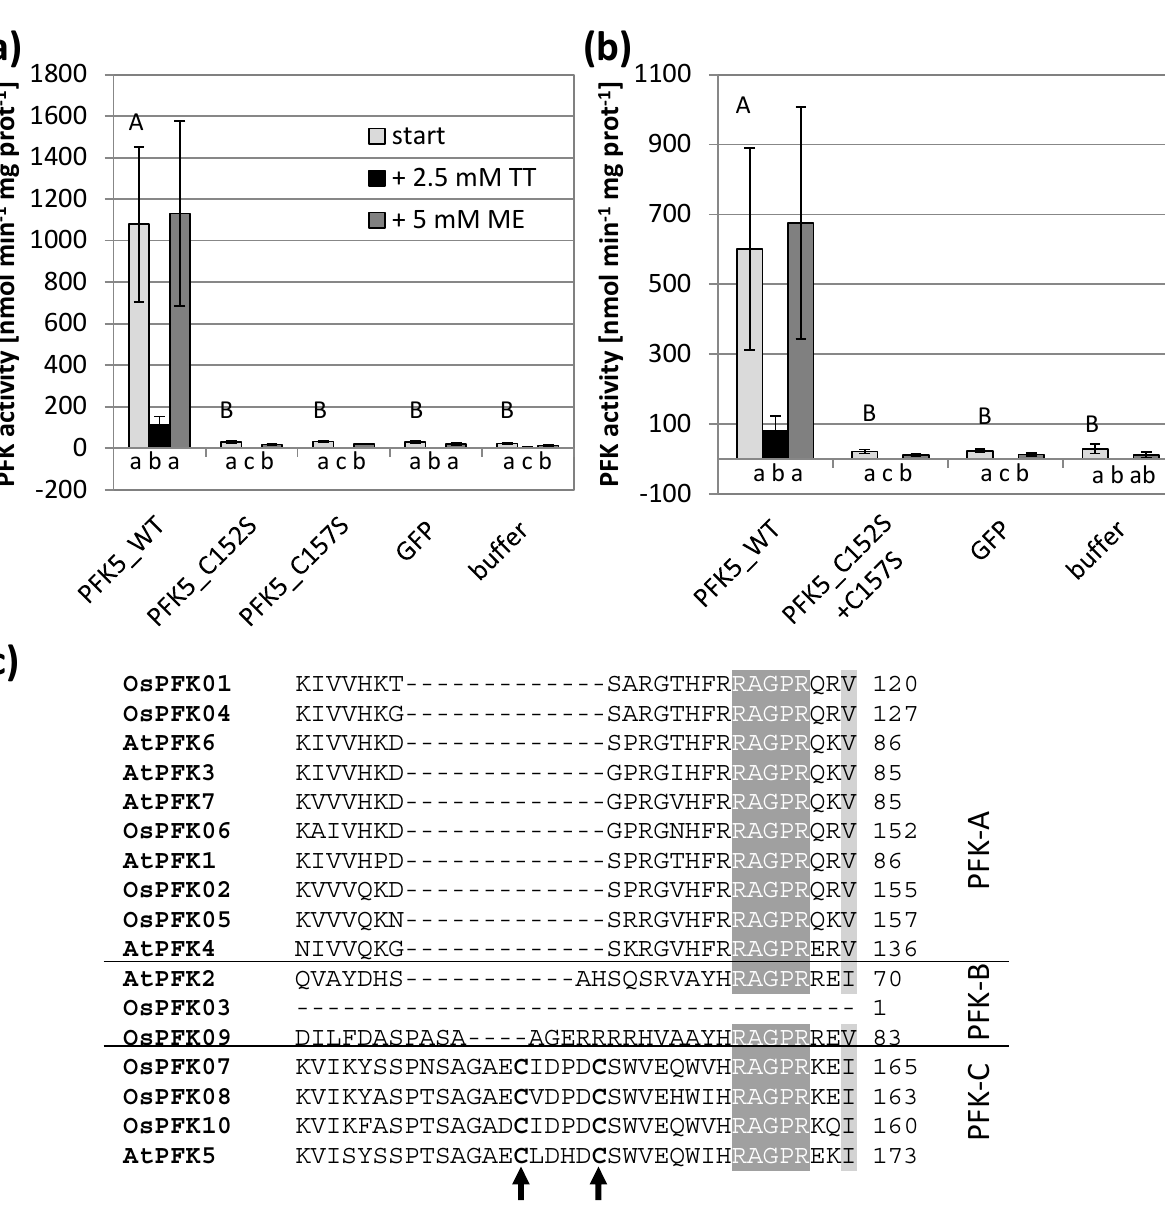
Figure 5. Impact of the CXDXXC motif on PFK activity and oxidation sensitivity. Single ( a ) and double ( b ) Cys to serine mutations were introduced in A. thaliana AtPFK5 proteins with CXDXXC motif. The variants were transiently overexpressed in tobacco leaves. Extraction buffer contained 5 mM β -mercaptoethanol ( β -ME). After determining the initial activity, samples were oxidized with 2.5 mM sodium tetrathionate (TT) for 20 min and afterwards re-reduced with 5 mM dithiothreitol (DTT). Upper case letters show significant differences for each isoform to buffer control, lower case letters indicate significant differences among treatments for each protein at p < 0.05 (ANOVA, Post hoc Tukey test, n = 3). ( c ) Detail of the protein alignment of the CXDXXC motif in PFKs from A. thaliana and O. sativa . The two mutated Cys are marked with an arrow.